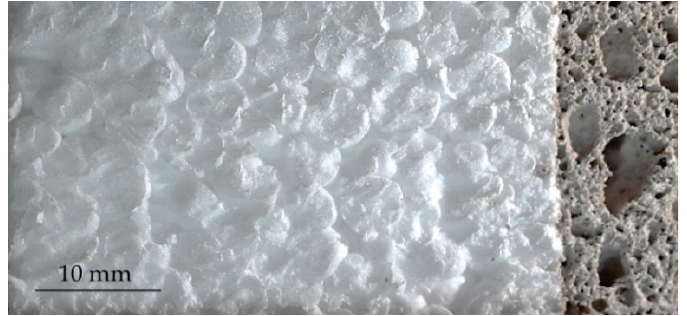
Figure 8. Section of the polystyrene board with a layer of S20. Three experimental tests were conducted with specimens 20, 15, and 10 mm thick.